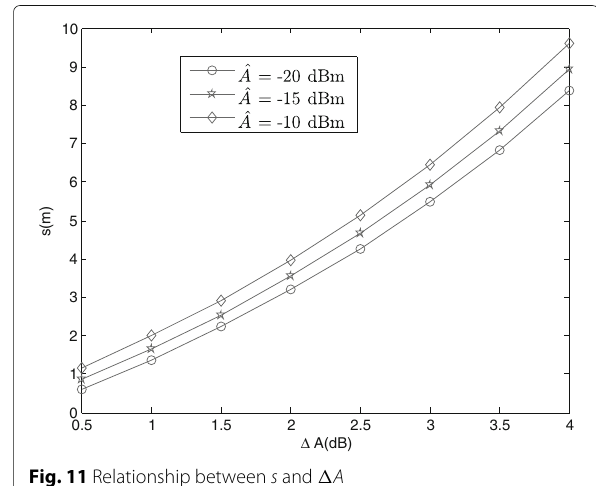
Fig. 11 Relationship between s and (cid:6) A